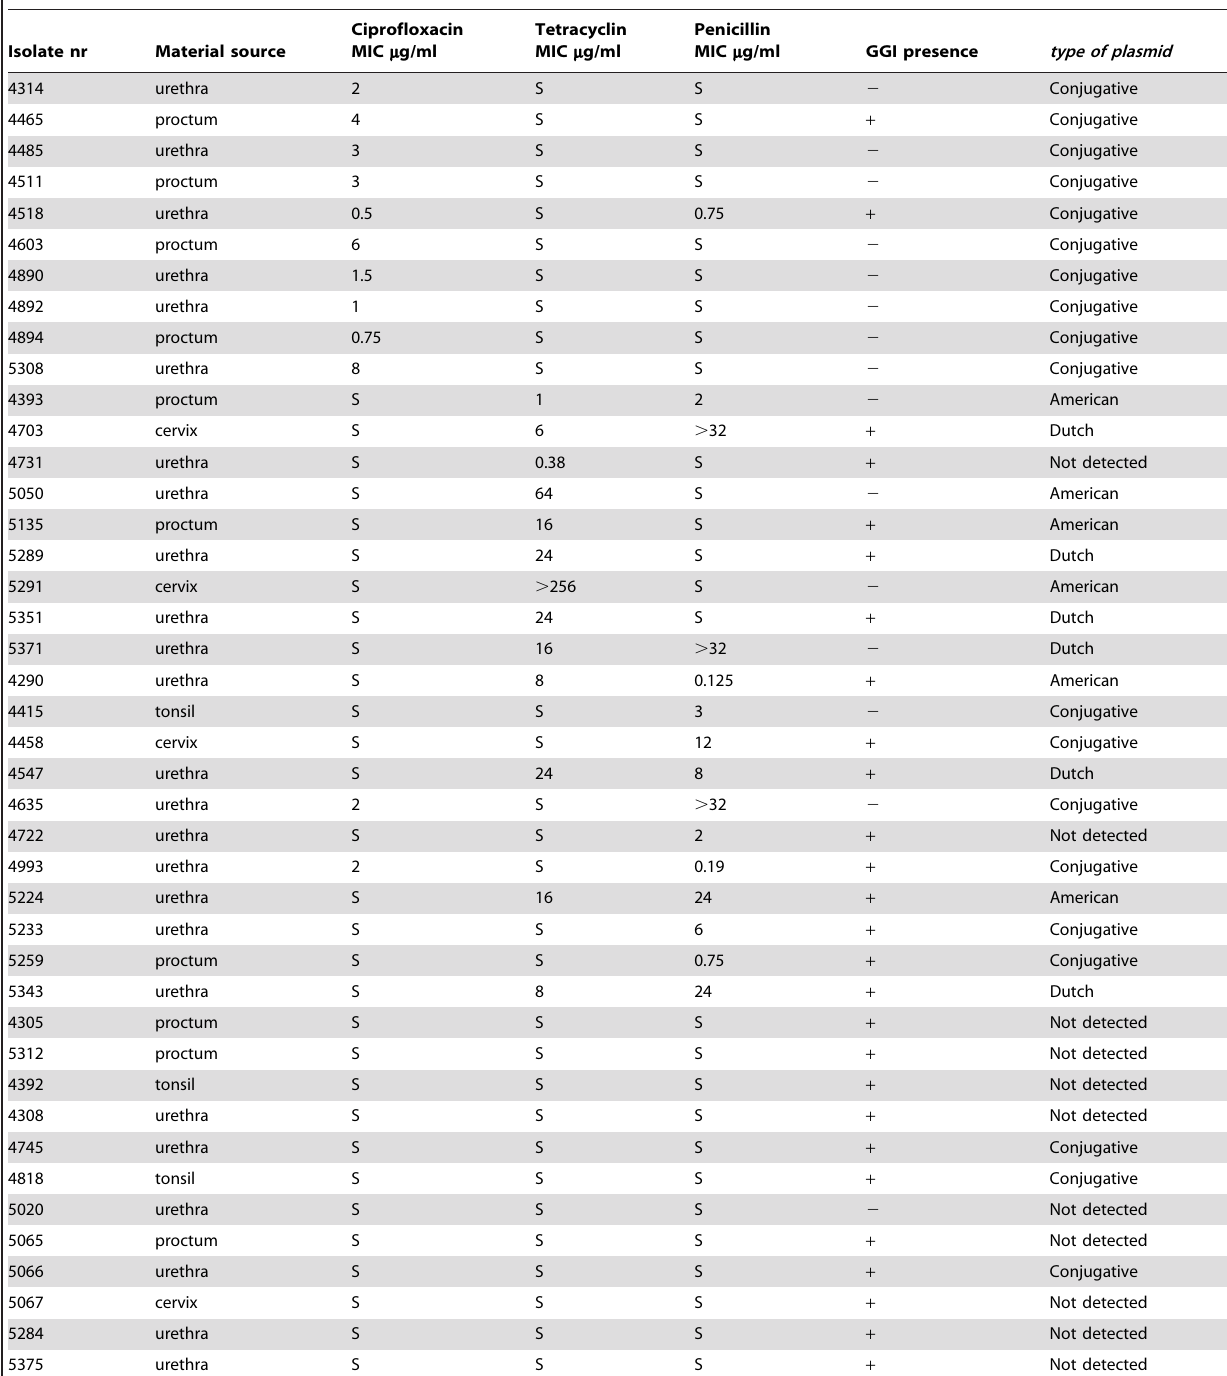
Table 1. Characteristics of clinical isolates used in this study